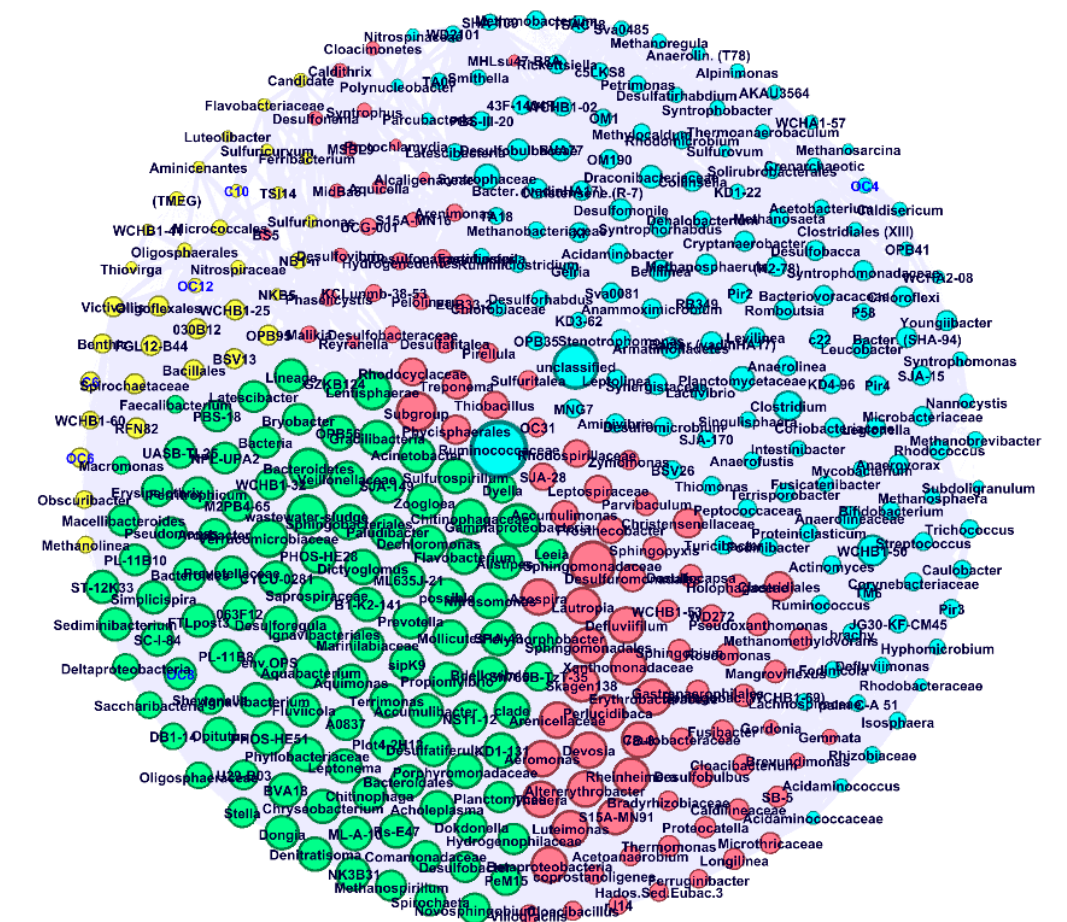
Figure 6. Co-occurrence network of biofilm and sludge of all reactors at genus level and AHL concentrations. The modularity of the nodes is differentiated by colors at genus level and AHL concentration. Only strong (Pearson’s R > 0.8) and significant ( p < 0.05) correlation connections were included, and nodes were labeled for genus (black) and AHL concentration (blue).